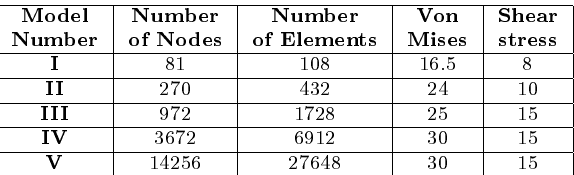
Tab. 2: Tire geometry speci(cid:28)cation for a P195/55 R16 85H.